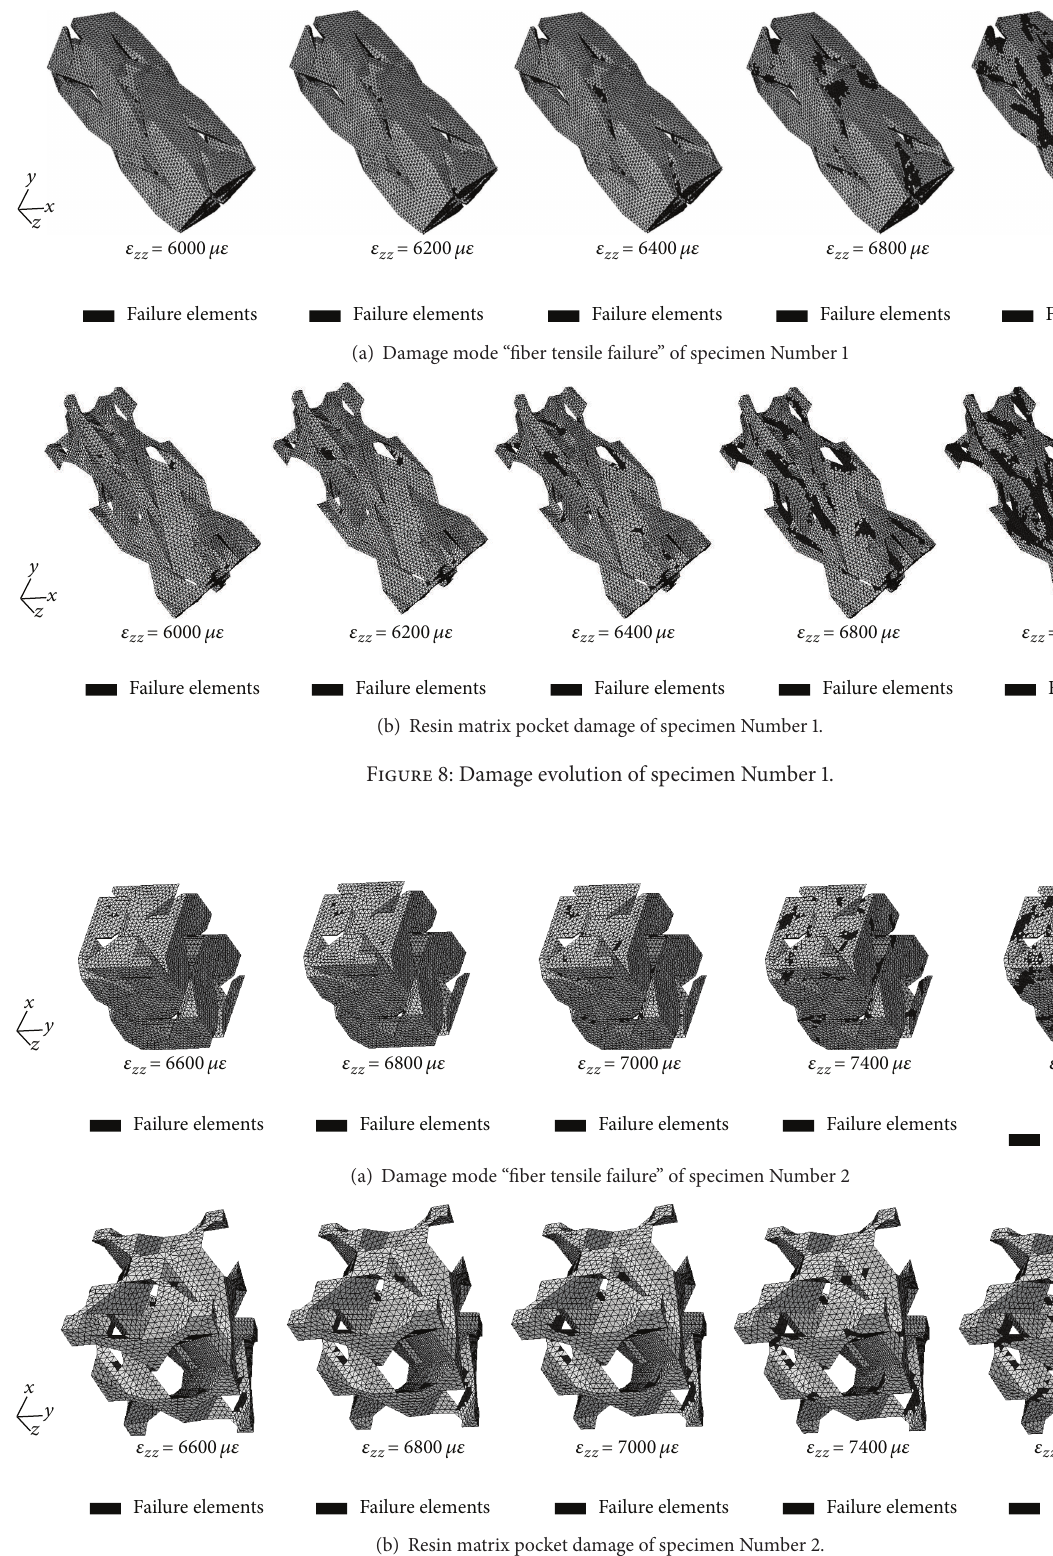
(b) Resin matrix pocket damage of specimen Number 2. Figure 9: Damage evolution of specimen Number